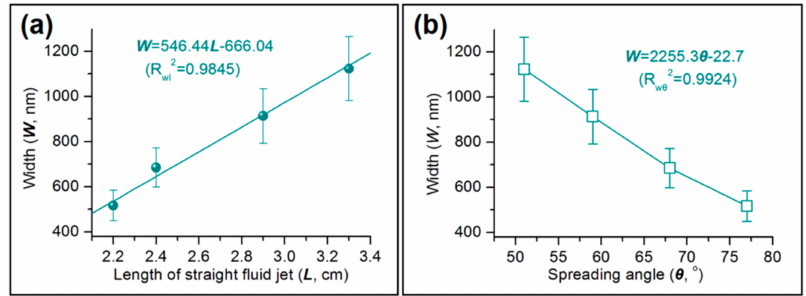
Figure 8. The correlations between the width of electrospun zein nanoribbons and: ( a ) The length of the straight fluid jet; and ( b ) the spreading angle of the unstable